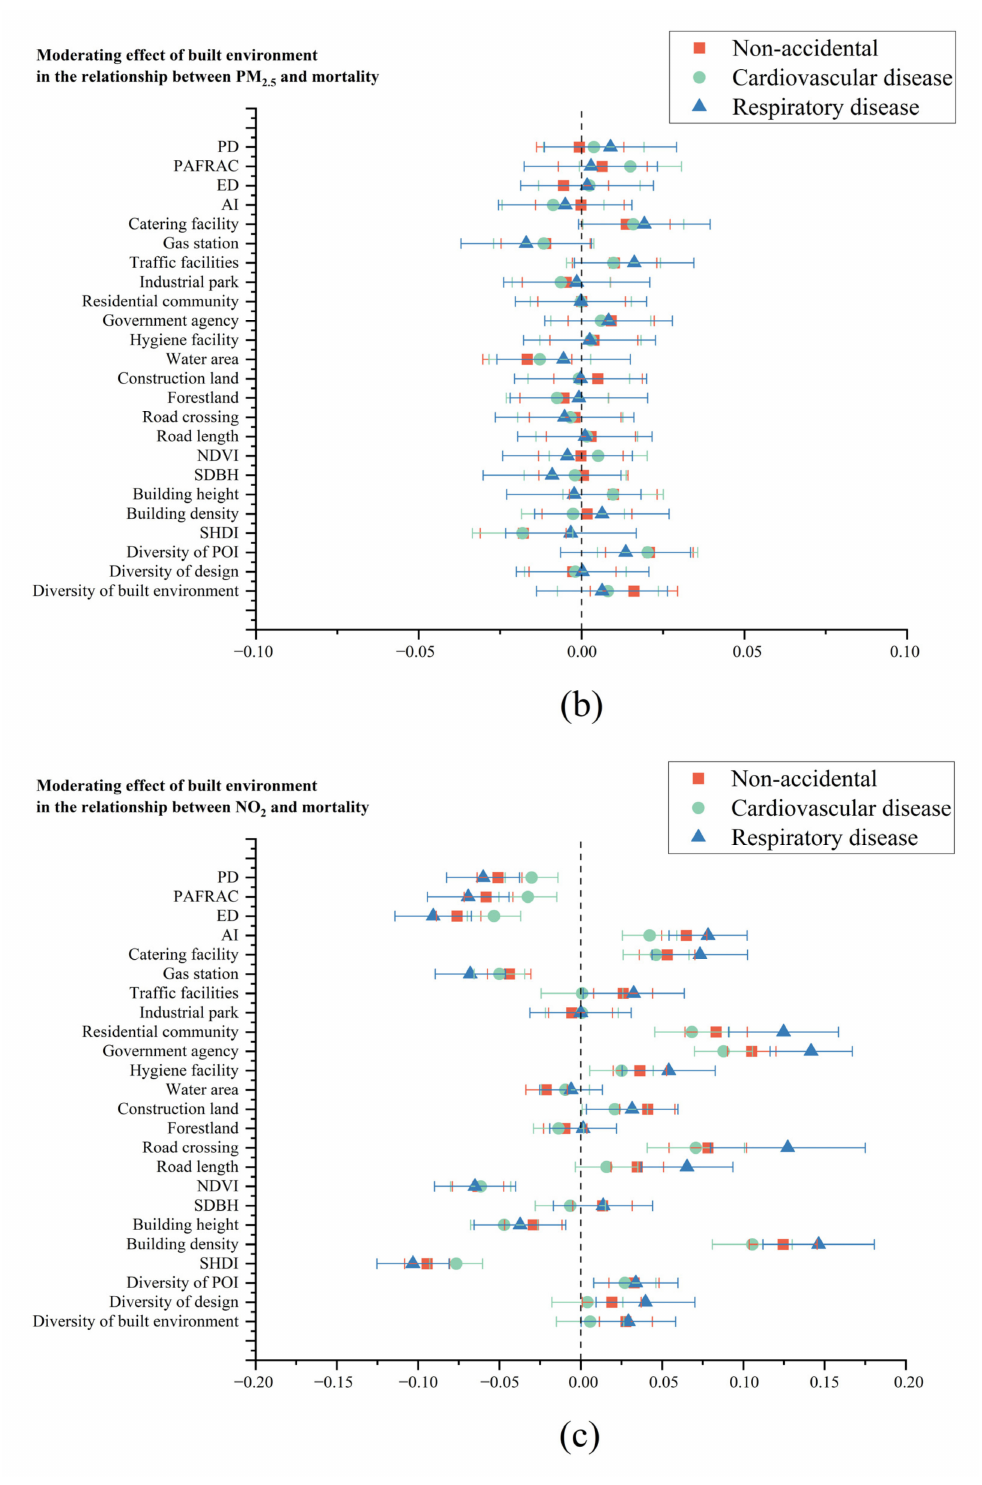
Figure 5. Moderating effect of the built environment in the relationship between air pollution and mortality in an unclassified area. ( a ) Moderating effect of the built environment in the relationship between O 3 and mortality; ( b ) moderating effect of the built environment in the relationship between PM 2.5 and mortality; ( c ) moderating effect of the built environment in the relationship between NO 2 and